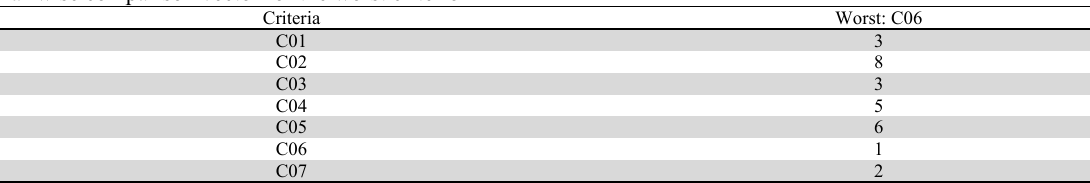
Criteria weights calculated by BWM